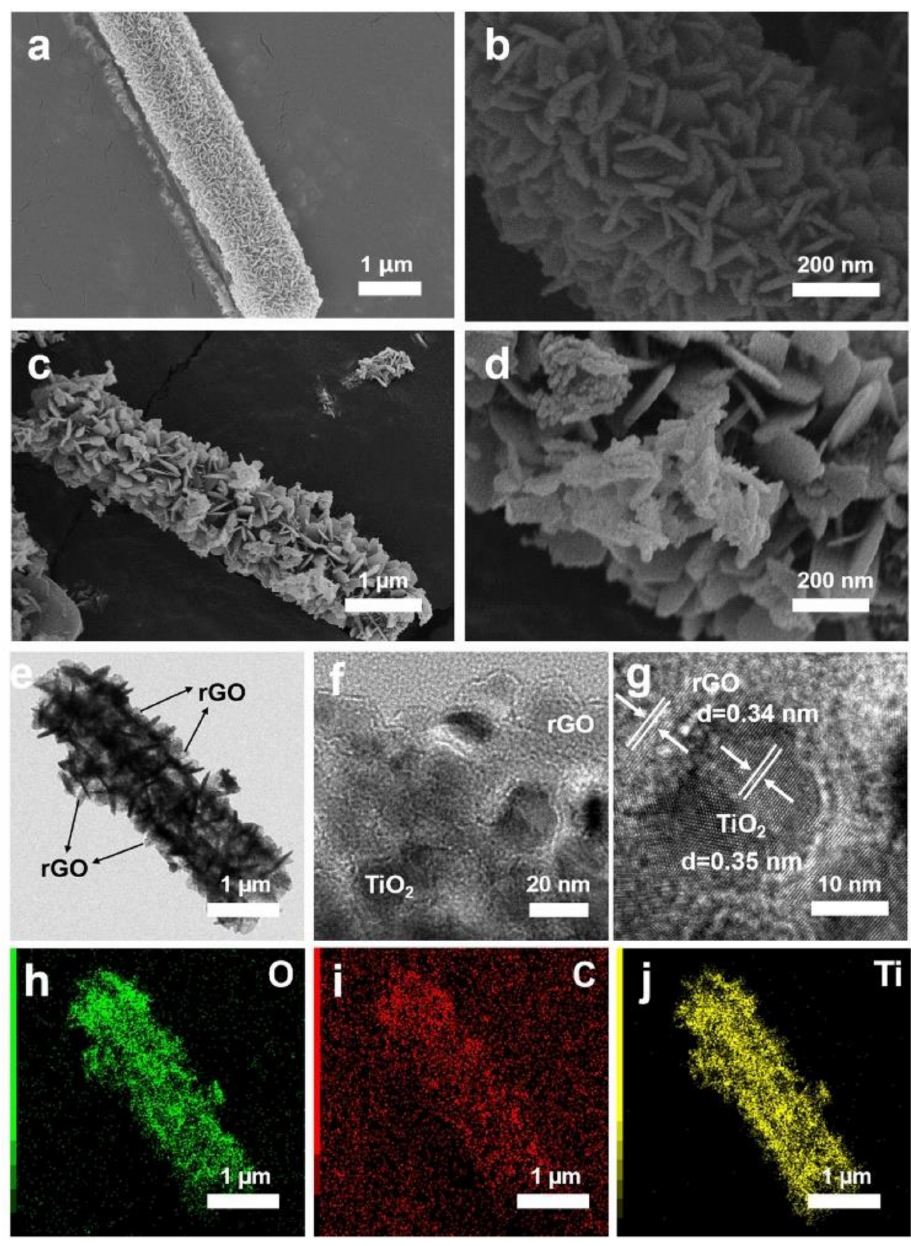
Figure 2. The SEM images of ( a , b ) TiO 2 and ( c , d ) rGO/TiO 2 , and the ( e ) TEM, ( f , g ) HRTEM images and ( h – j ) elemental mappings of the rGO/TiO 2 heterojunction